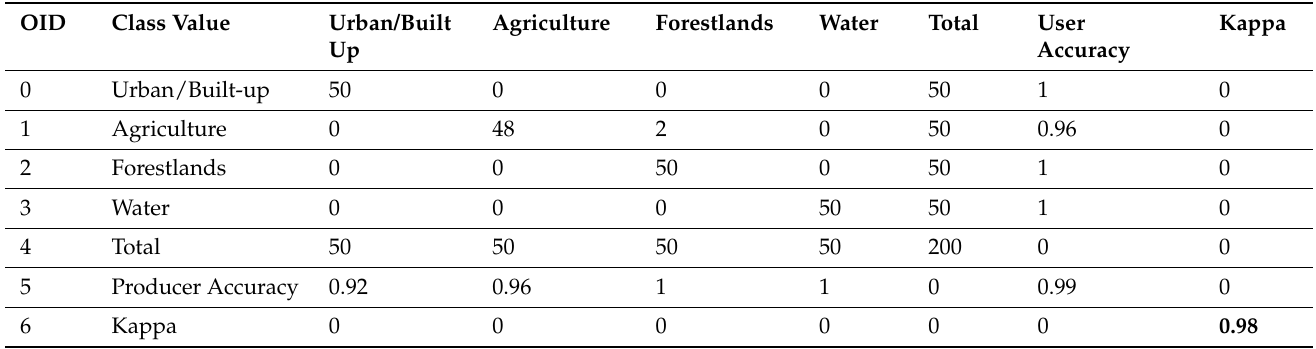
Table A4. User, Producer, and Kappa statistics for the classified image of